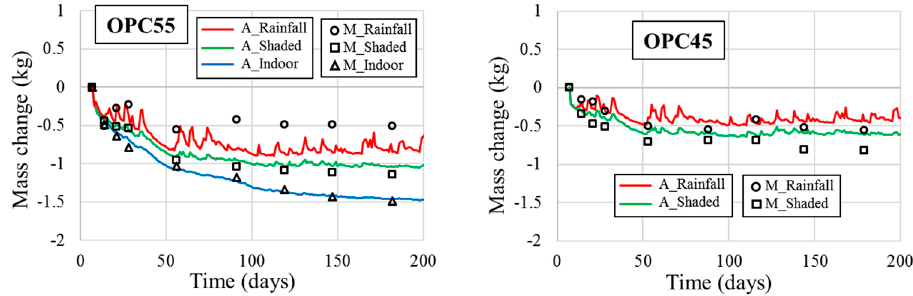
Figure 5. Mass change of each series (M-Measured & A-Analytical).